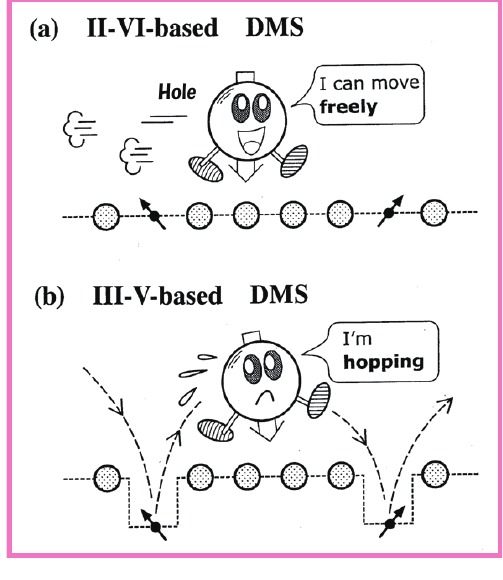
Figure 17. An illustration of the difference between the characters of a hole in a II-VI-based DMS and in a III-VI-based